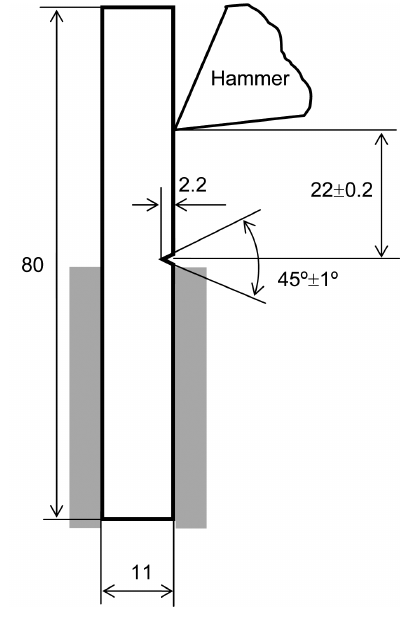
Fig. 1. Dimensions of Izod impact test